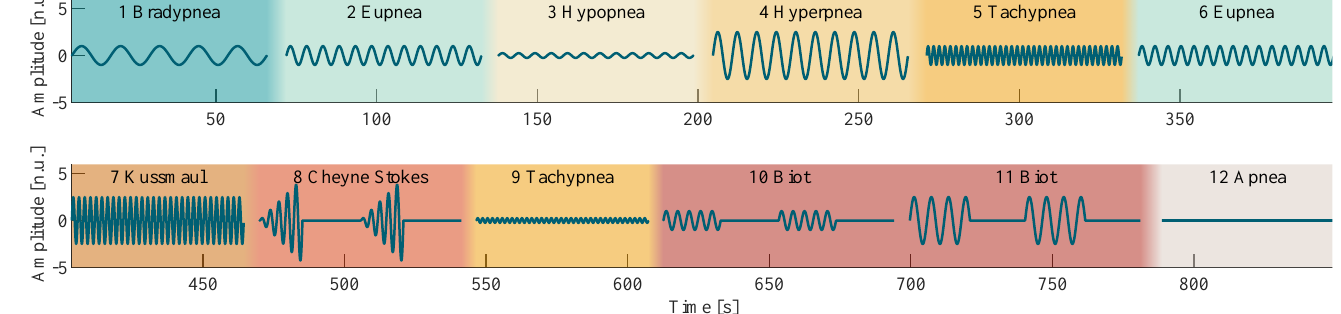
Figure 2. Visual representation of the breathing-pattern reference signal. A pause is placed between each breathing pattern to allow the subjects to breathe